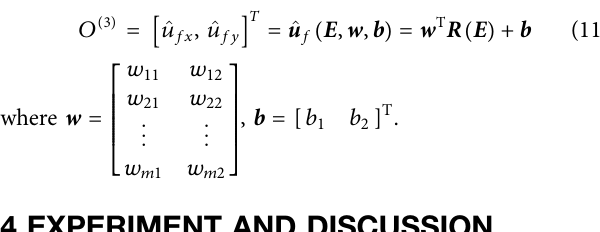
Frontiers in Materials |